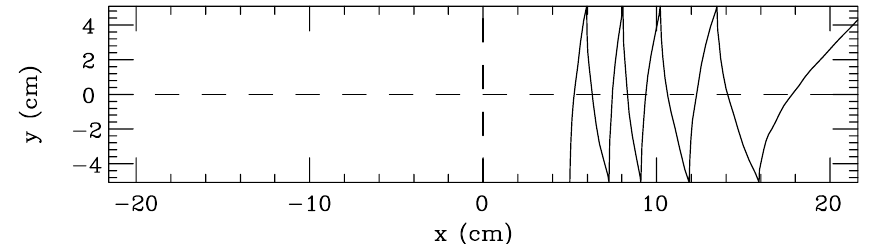
FIG. 3. Trajectory of an electron launched 5 cm from the midline in CESR rectangular waveguide propagating the TE 10 mode. 032001-2